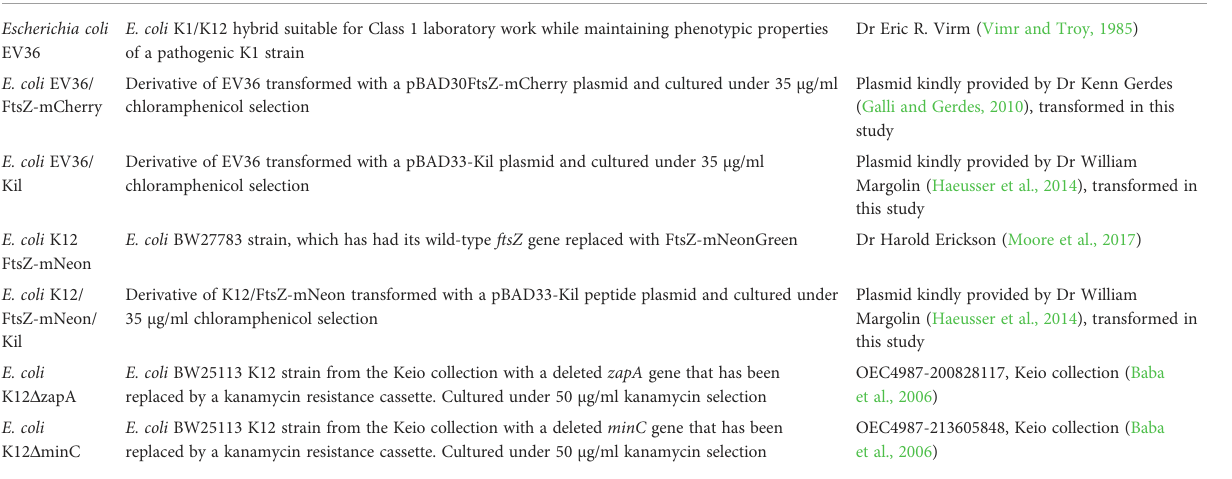
TABLE 1 Bacterial strains used in this study.